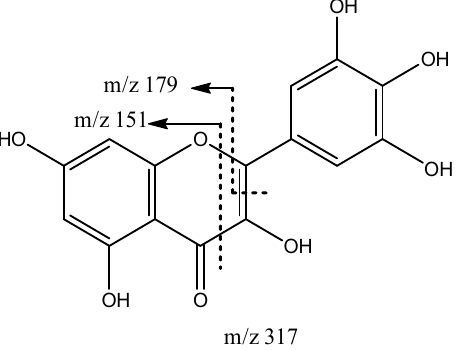
Figure 19. Myricetin fragmentation.